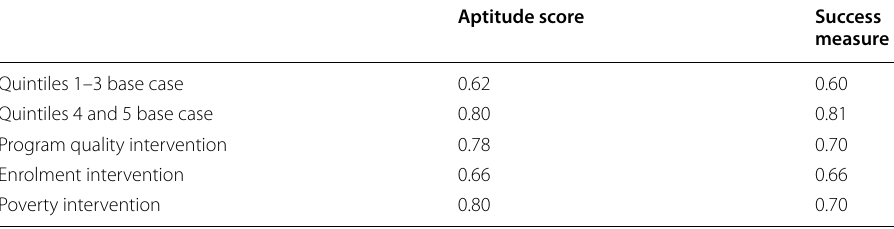
Table 14 Summary of the base case and intervention results for the ECDM Aptitude score Success